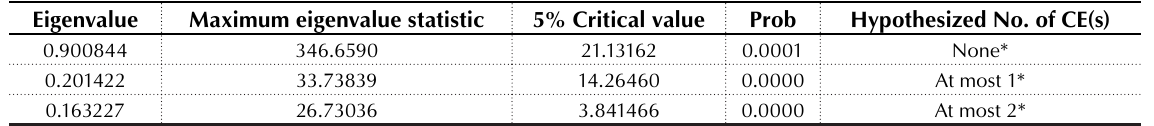
Source: researcher’s computation (2017).